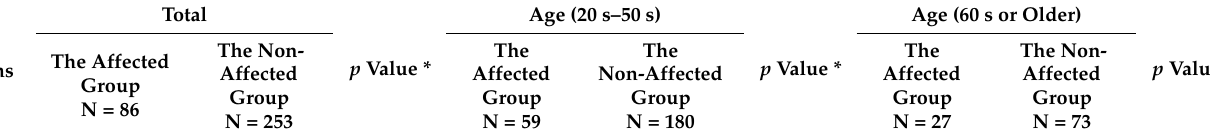
Table 3. Differences in KAP between two residential groups: univariate analysis stratified by age. (Number (%)).